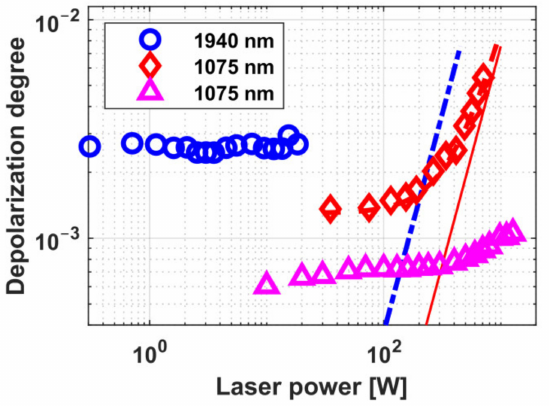
Figure 9. Power dependence of radiation depolarization in FIs based on CVD-ZnSe elements for a wavelength of 1940 nm (circles—experiment, dash-dot line—calculation [47]) and for a wavelength of 1075 nm (diamonds—experiment, dashed curve—calculation [47], triangles—experiment